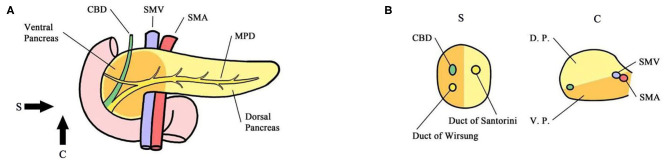
(A) Sagittal view. (B) Coronary view. The pancreas is codeveloped from the ventral and dorsal primordium, which mainly constitute the body and tail of the pancreas and anterior partial head of the pancreas (yellow). The ventral primordium develops into the posterior part of the head of the pancreas that surrounds SMA/SMV. The head of the pancreas was divided into the ventral and dorsal pancreatic head by the line that links the portal vein (PV)/superior mesenteric vein (SMV) and anterior edge of the intrapancreatic bile duct. The main pancreatic duct of the common bile duct was located in the ventral pancreatic head, and the accessory pancreatic duct was located in the dorsal pancreatic head. CBD Common Bile Duct MPD Main Pancreatic Duct SMA Superior Mesenteric Artery SMV Superior Mesenteric Vein DP Dorsal Primordium VP Ventral Primordium.